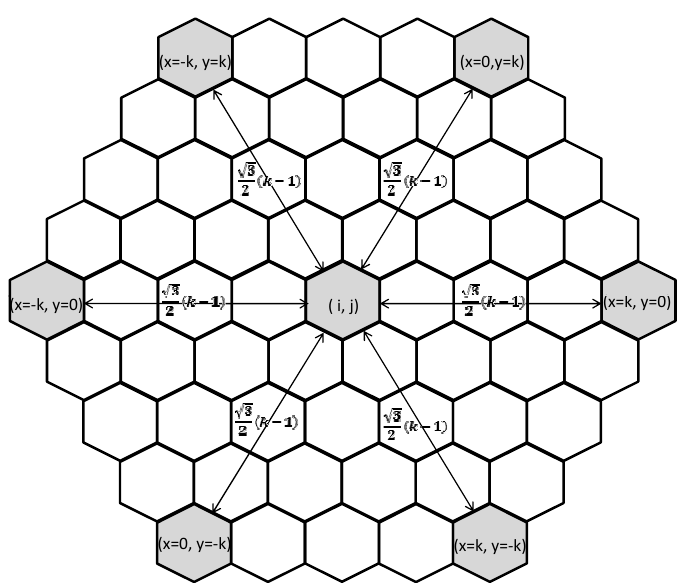
Figure 2. The Minimum Distance Between Two Nodes with Same Color.